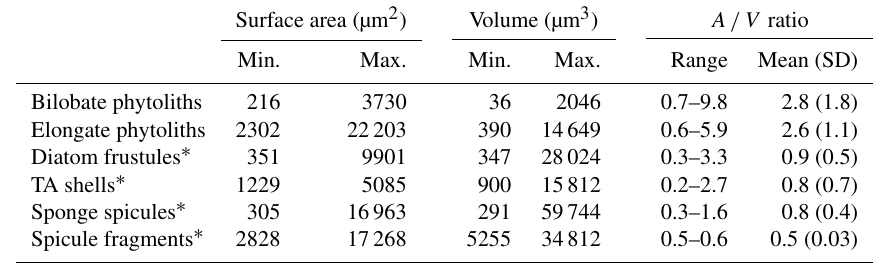
Table 4. Surface areas, volumes and surface-to-volume ratios ( A/V ) of different biogenic siliceous structures found at Chicken Creek.